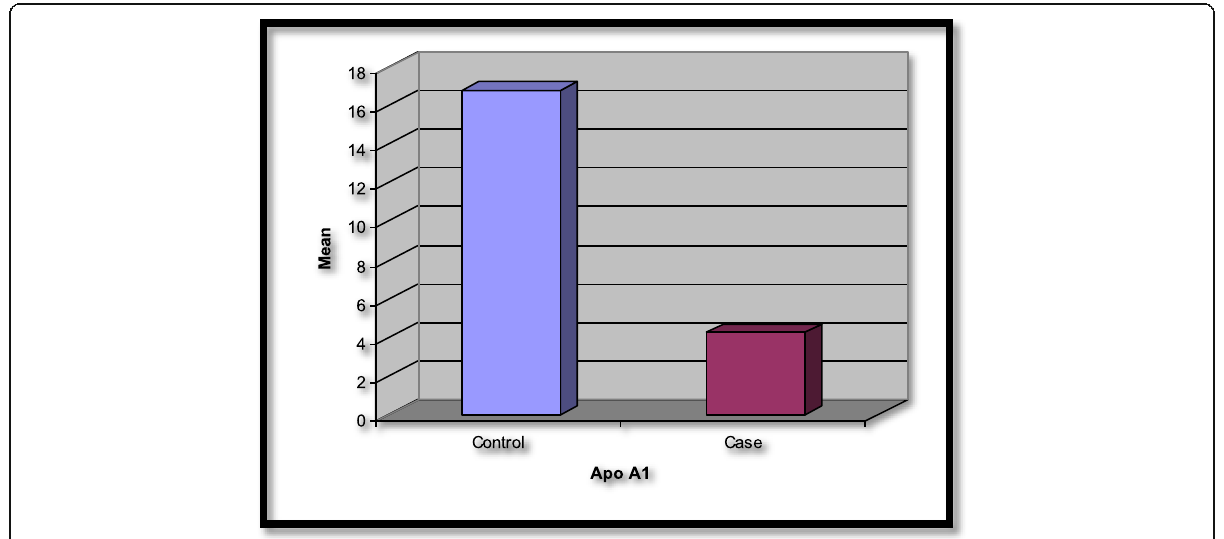
Fig. 1 Comparison between cases and controls as regards ApoA1 level using Student t test